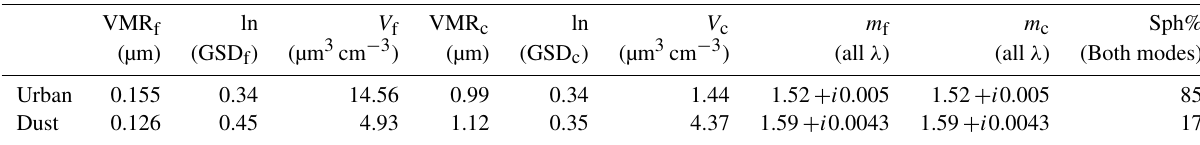
Table 4. State parameters ( x 0 ,i ) and their values for the bimodal aerosol test cases. The subscripts f and c denote fine and coarse mode,